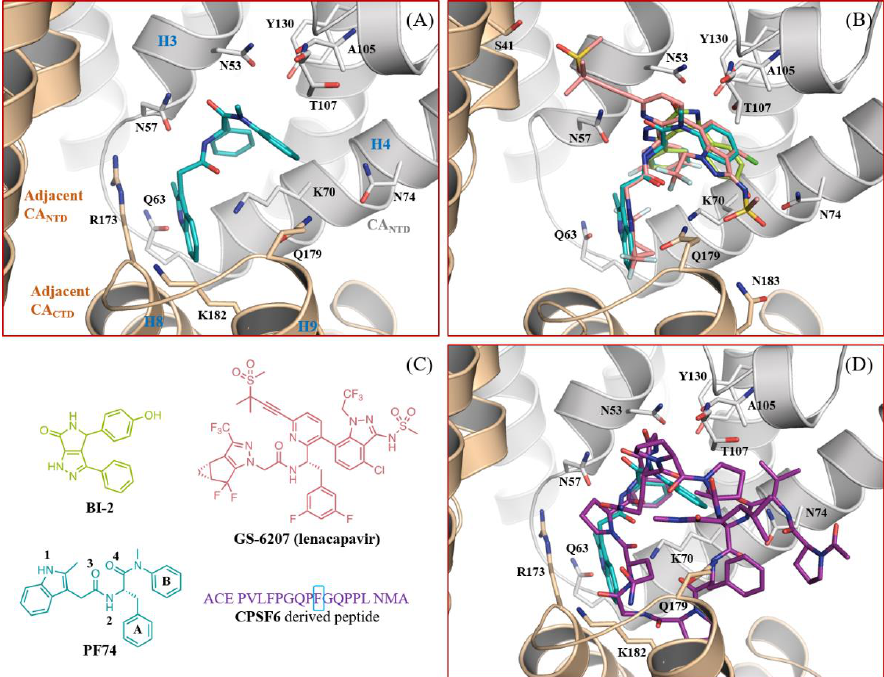
Figure 1. Structure of HIV-1 capsid protein (CA) and key CA-ligand and -host binding pocket. ( A ) Binding of PF74 on HIV-1 capsid protein (PDB code: 4XFZ [17]). PF74 occupies a binding pocket formed around alpha-helices H3 and H4 in CA NTD (grey) and H8 and H9 in adjacent CA CTD (orange). Two other CA-targeting small molecule chemotypes, BI-2 [10] and GS-6207 [14,15], as well as host proteins CPSF6 and NUP153 [18], also occupy this same pocket; ( B ) superimposition of PF74, BI-2, and GS-6207 in the same binding pocket; ( C ) chemical structures of PF74, BI-2 and GS-6207, and amino acid sequence of host protein CPSF6 derived peptide. The boxed (cyan) phenylalanine residue corresponds with the phenylalanine moiety of PF74 in the binding pocket; ( D ) superimposition of PF74 and CPSF6 derived peptide (PDB code: 4U0A [18]) in the same binding pocket. Viruses 2021 , 13 , x FOR PEER REVIEW